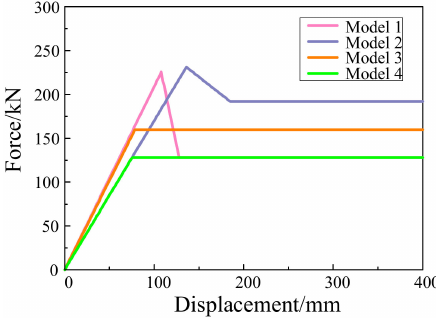
Figure 14. Comparison of different LRB models. Table 7. Mechanical parameters of